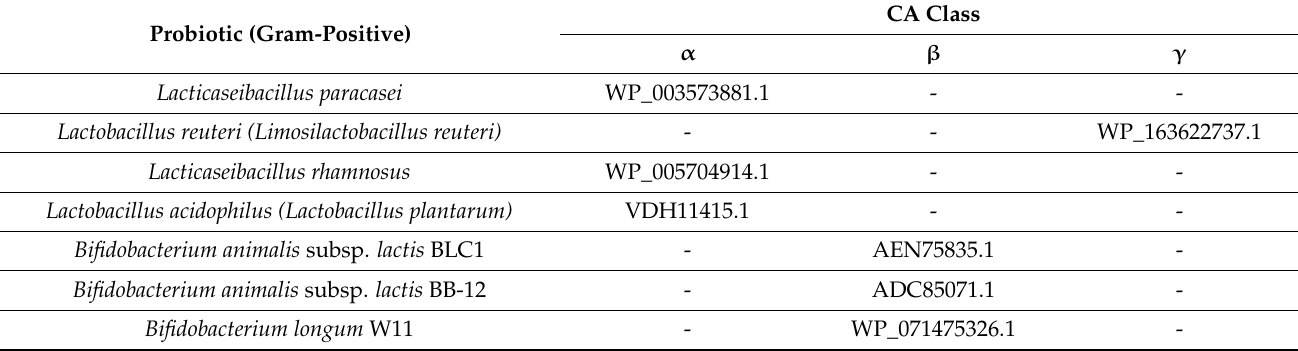
Table 4. CA classes and their accession numbers identified in the genome of the considered probiotics. Probiotic (Gram-Positive)